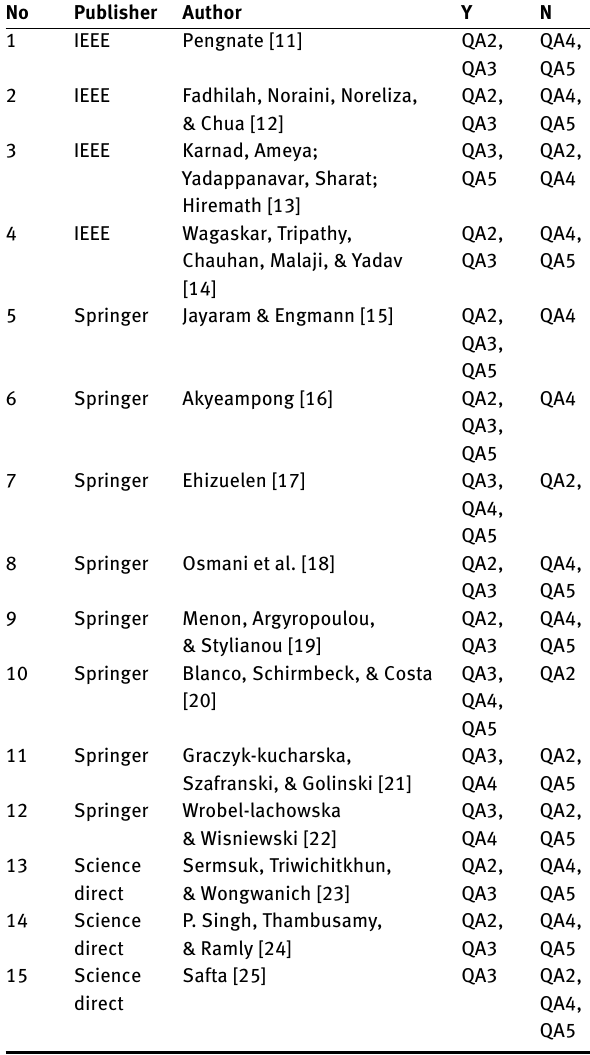
Table 2: Quality